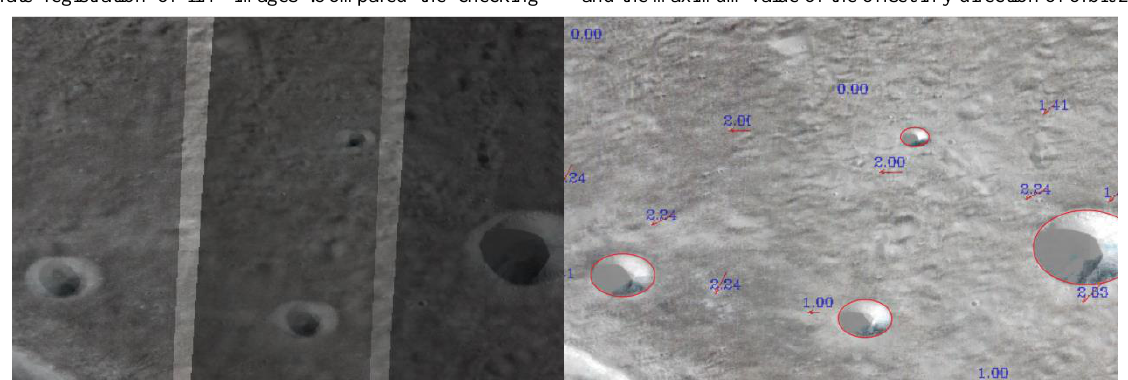
Figure 6.The results of comparison before and after